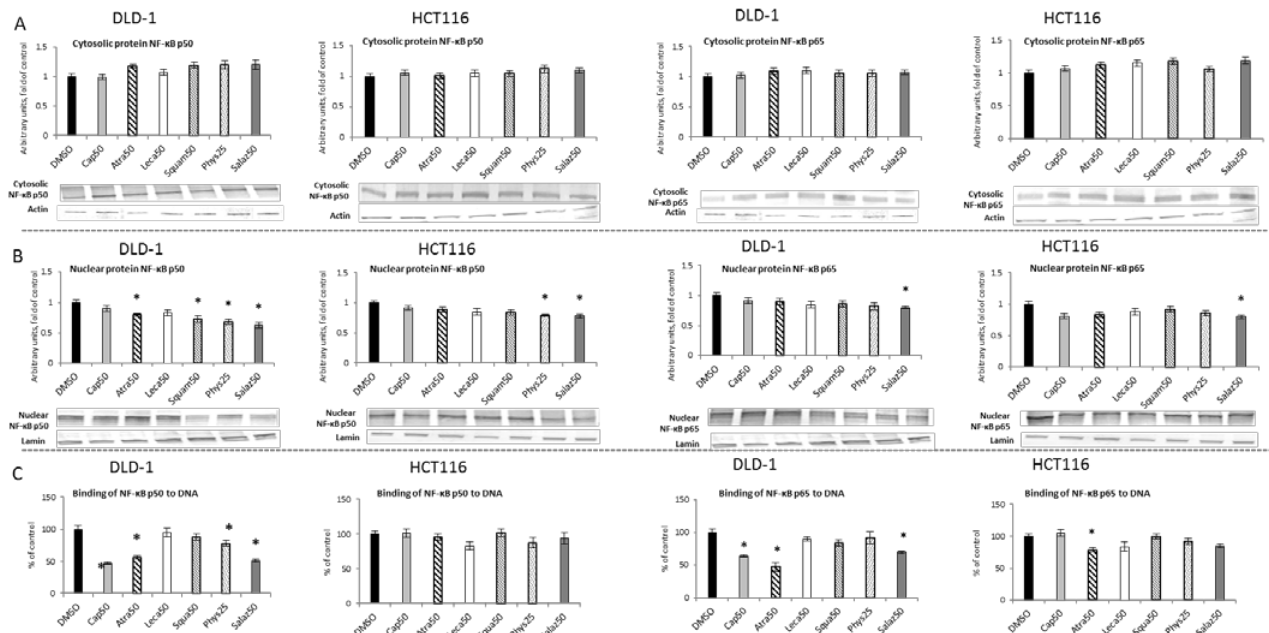
Figure 6. The effect of lichen-derived compounds on NF- κ B activation in DLD-1 and HCT116 cells. ( A ) The levels of NF- κ B p50 and p65 proteins in the cytosolic fraction. ( B ) The levels of NF- κ B p50 and p65 proteins in the nuclear fraction. Representative Western immunoblots are presented under the graphs ( A , B ). Results (means ± SEM from three separate experiments) are presented as a fold change to control after normalization against the level of actin or lamin. ( C ) The levels of NF- κ B p50 and p65 binding to DNA. Results are presented as the means ± SEM from three separate experiments percentage of control). Asterisks (*) denote statistically significant changes from the control group ( p ≤ 0.05). DMSO , vehicle control; Cap50 , caperatic acid (50 µM); Atra50 , atranorin (50 µM); Leca50 , lecanoric acid (50 µM); Squam50 , squamatic acid (50 µM); Phys25 , physodic acid (25 µM); Salaz50 , salazinic acid (50 µM).